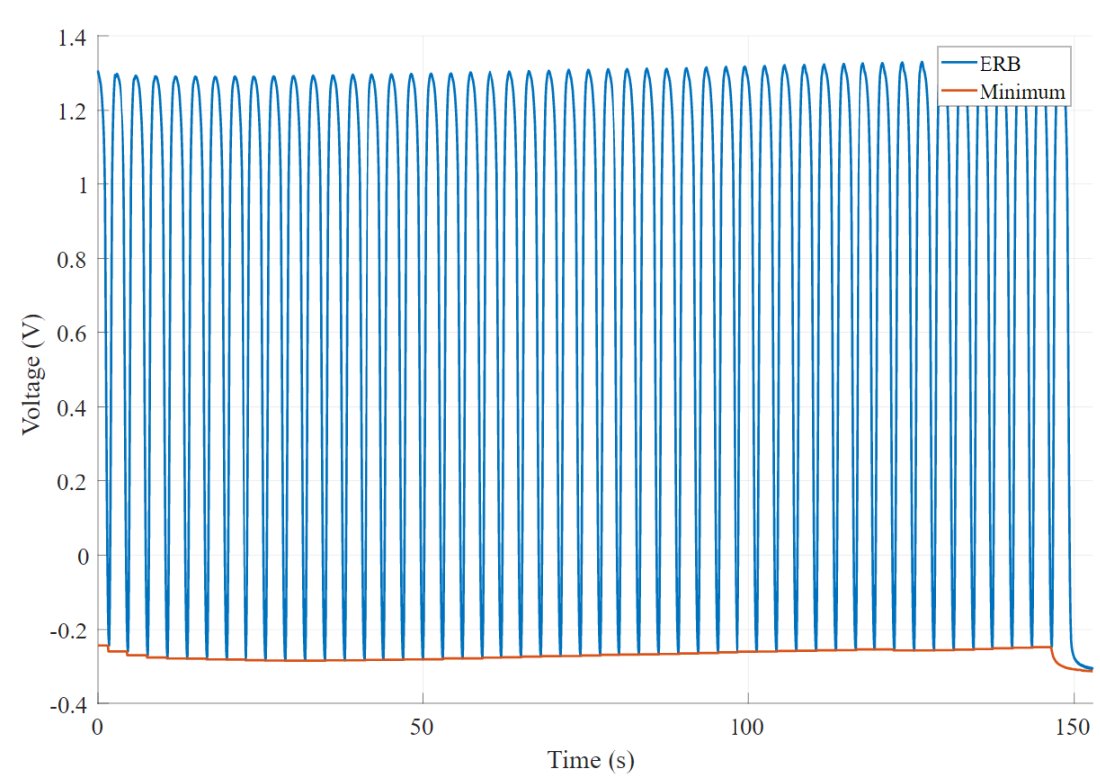
Figure 7. An example of desired voltage output where baseline remains relatively unchanged with